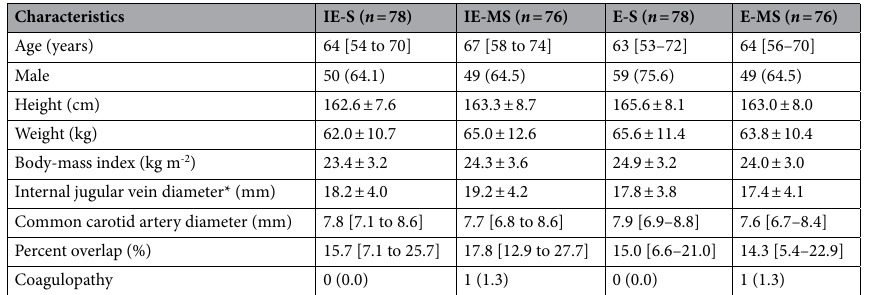
Table 1. Comparison of baseline characteristics of patients between the four groups according to the practitioner’s experience and catheterization techniques ( n = 308). Values are presented as median [IQR], number (proportion) or mean ± SD. Ultrasound-guided internal jugular vein catheterization was performed using either Seldinger technique or modified Seldinger technique by inexperienced practitioners in IE-S and IE-MS groups, respectively. Meanwhile, ultrasound-guided internal jugular vein catheterization was performed using either Seldinger technique or modified Seldinger technique by experienced practitioners in E-S and E-MS groups, respectively. IE-S = inexperienced Seldinger technique, IE-MS = inexperienced modified Seldinger technique, E-S = experienced Seldinger technique, E-MS = experienced modified Seldinger technique. *There were two cases of missing data about vessel diameters in E-S and E-MS groups,